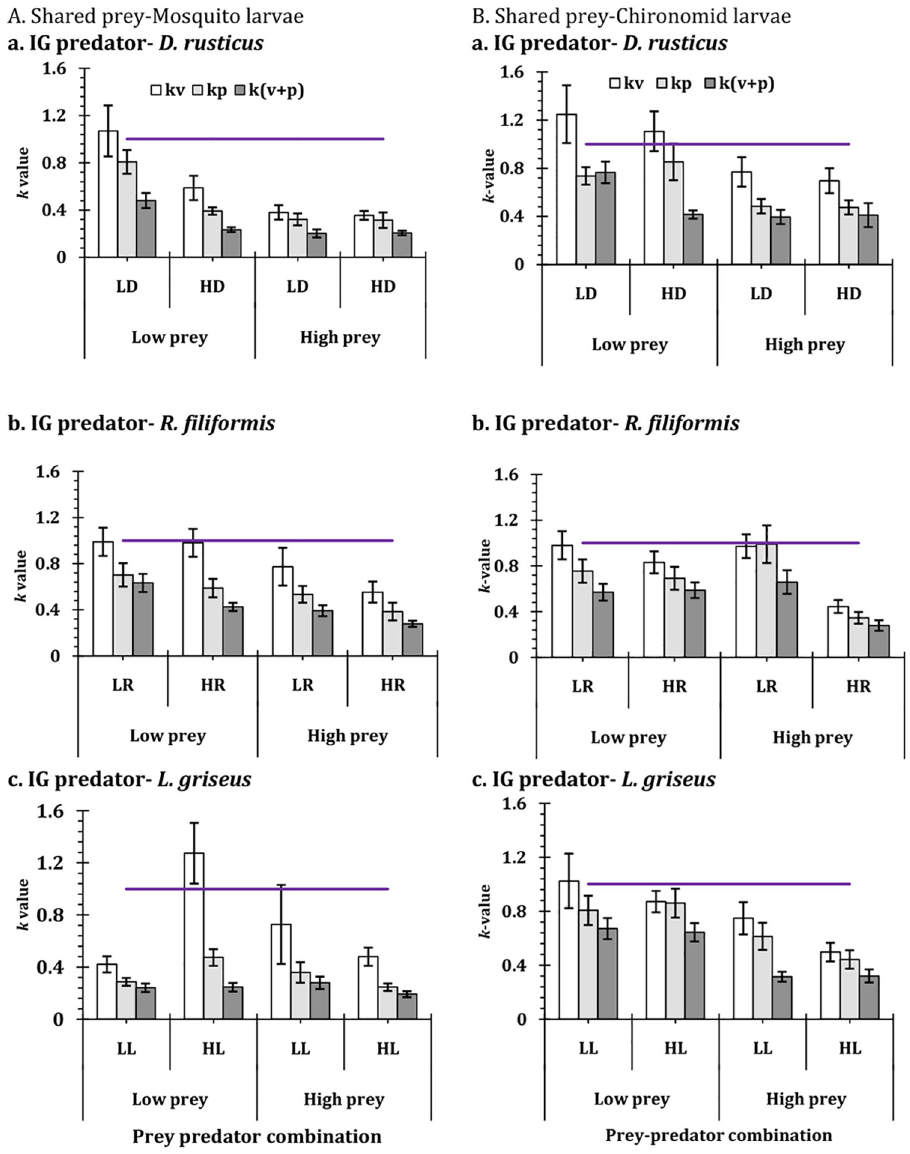
Fig 6. Mortality of IG prey ( A . bouvieri ) in presence of different shared prey ( A. mosquito larvae and B. chironomid larvae ) in complex habitat conditions (v–vegetation, p–pebbles and v+p—vegetation and pebbles) against open conditions expressed as a ratio ( k– value, mean ± SE) for the three IG predators, in IGP system , in two density (L– 2 individuals and H—4 individuals) under low and (50 individuals) and high (200 individuals) prey density. The horizontal lines in each graph represents the value of